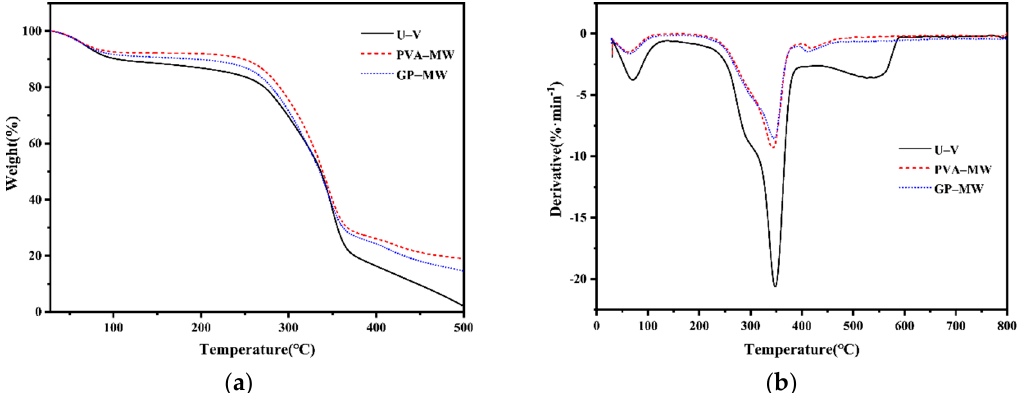
Figure 10. The TG and DTG for the untreated veneer, PVA and Gr/PVA impregnated modified veneers: ( a ) TG curves; ( b ) DTG curves.